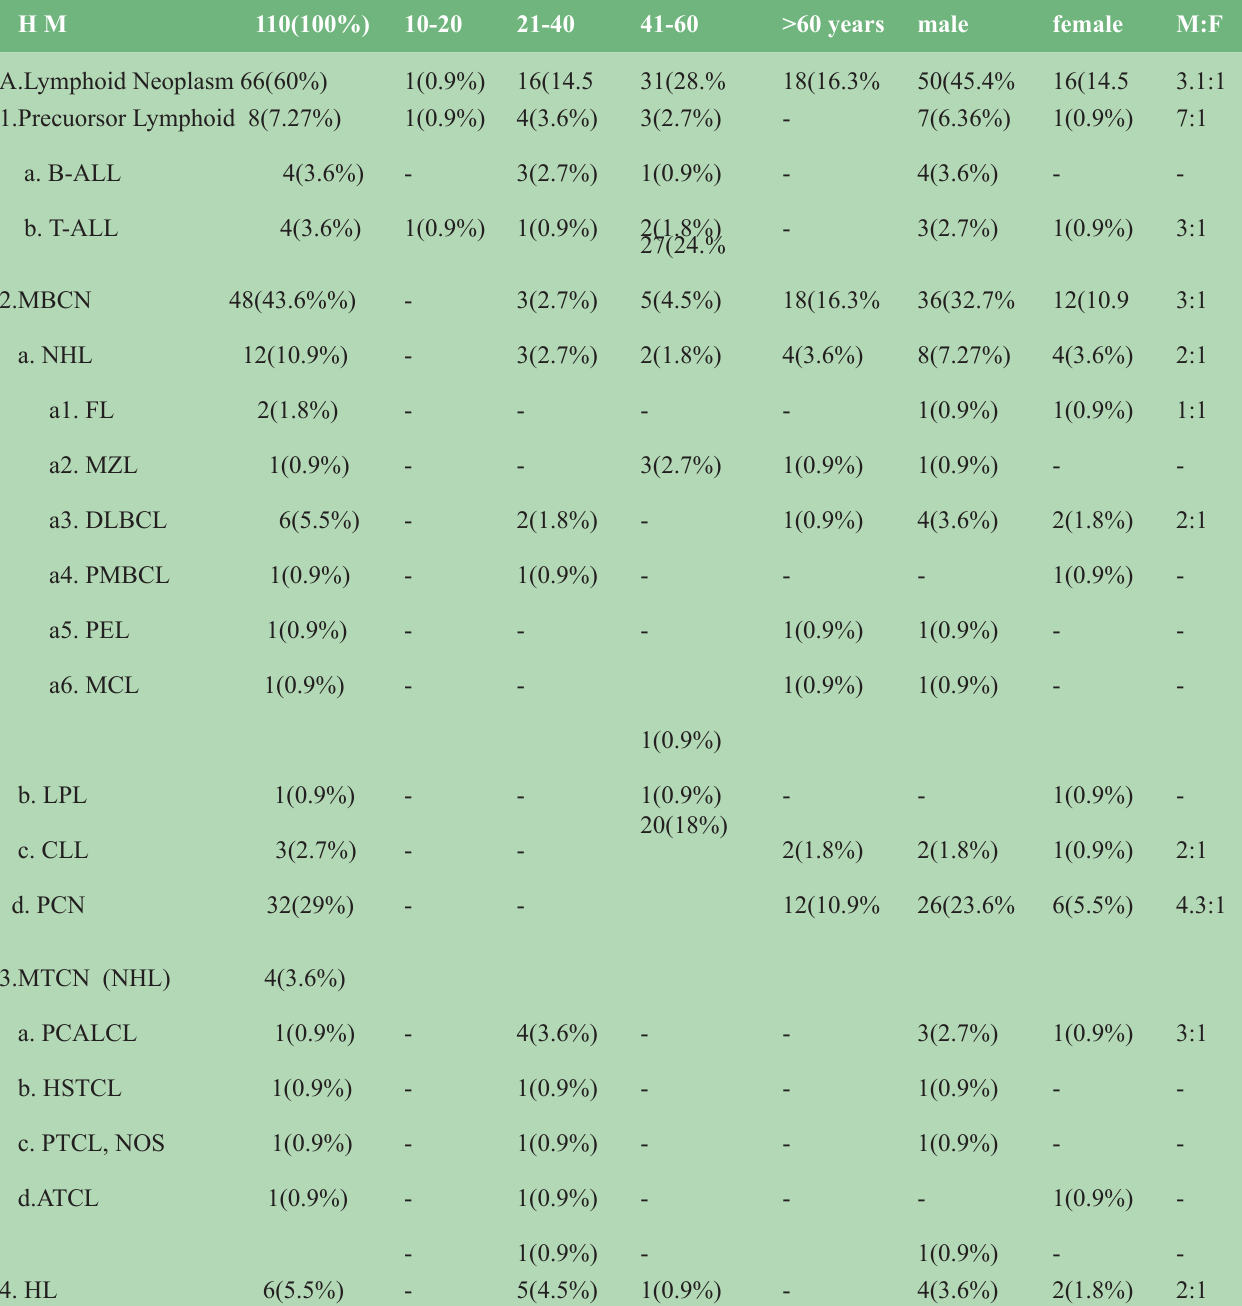
Table 1 Frequency and Distribution pattern of age (years) and sex in Lymphoid Neoplasm H